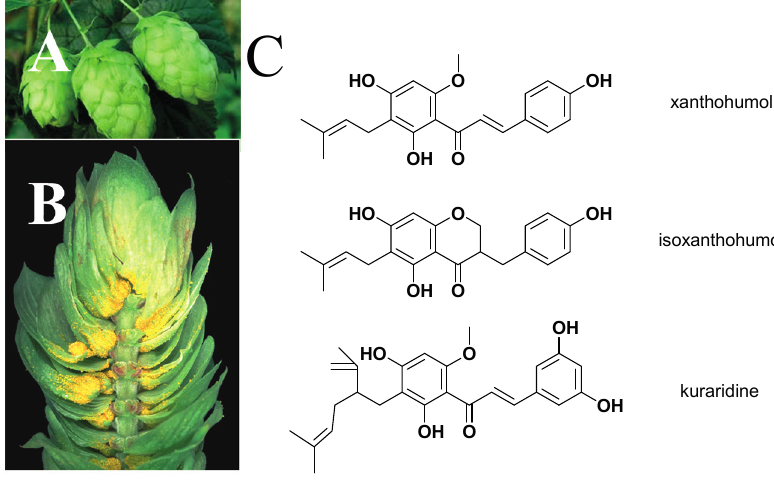
Figure 1. Female hop flowers ( A ); hop flowers resin covering flower bracts ( B );